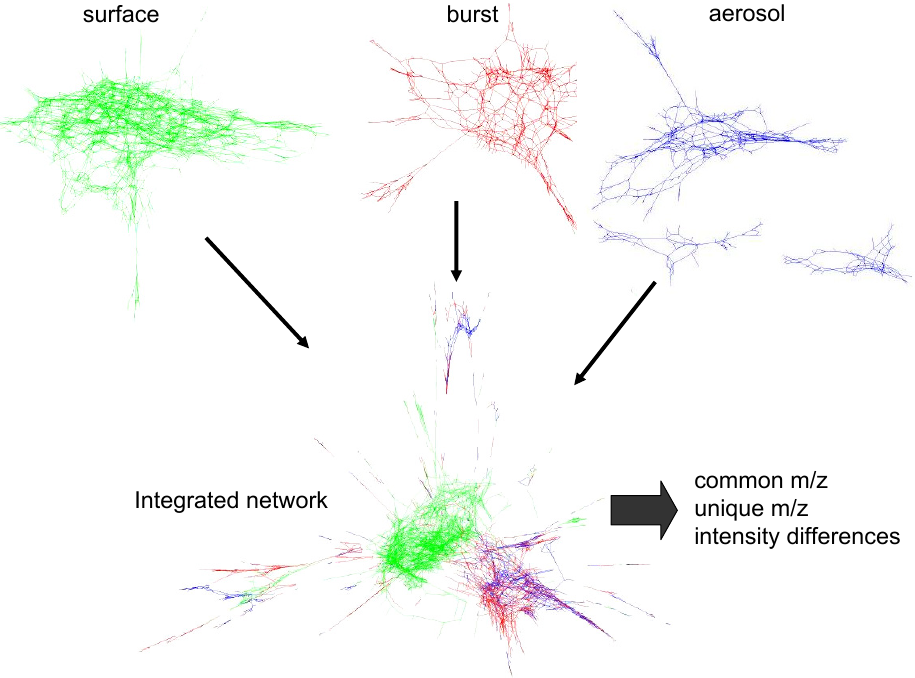
Fig. 6. Compositional network representation of the mass differences connected with m/z showing the looser network in the order sur- face/burst/aerosol and their integration in the final network enabling to filter the common, unique signals for process